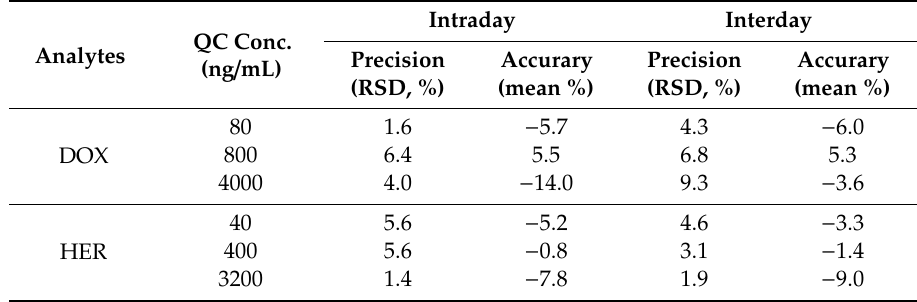
Table 2. Precision and accuracy of doxorubicin and hernandezine in plasma of rats (n = 5). RSD: relative standard